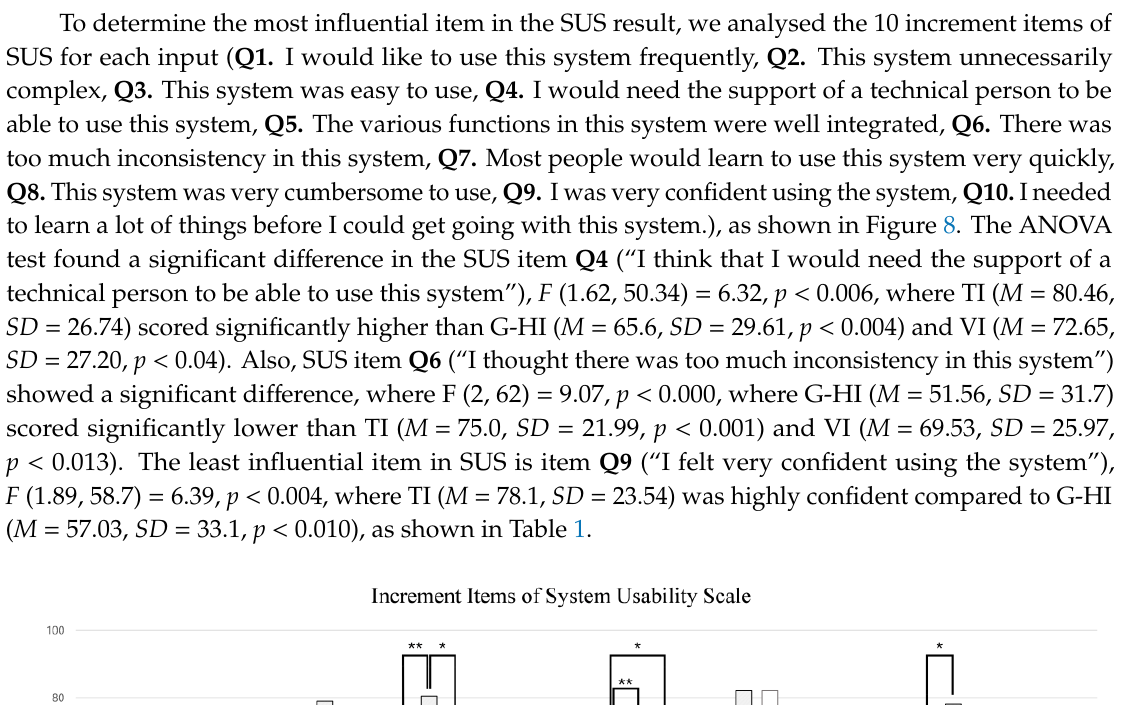
Figure 7. Average system usability scale (SUS) scores for the three input interactions.